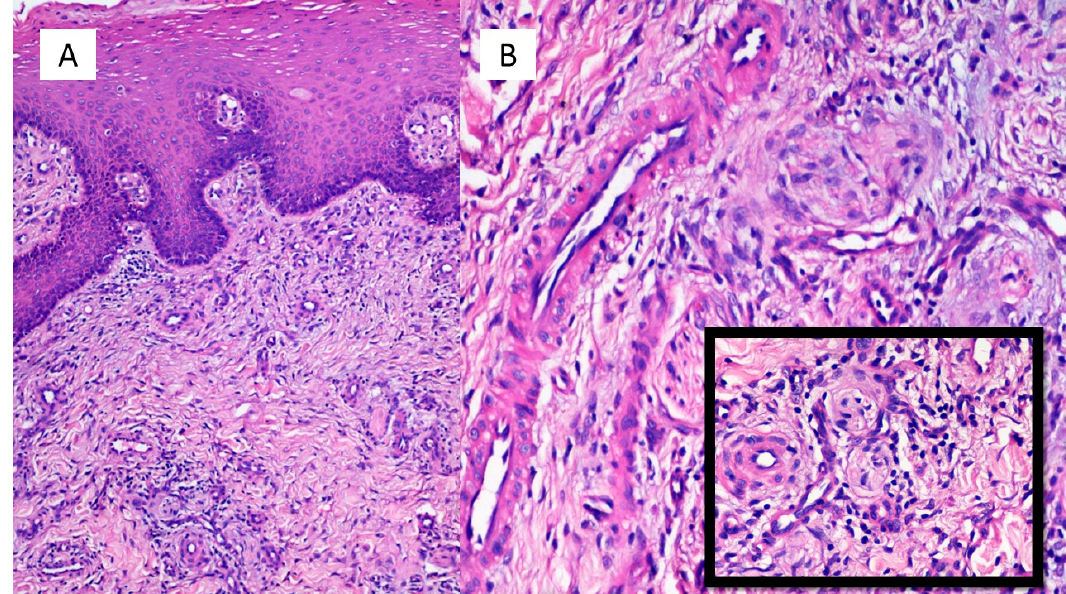
Figure 2. ( A ) Epidermis with modest hyper-parakeratosis, sometimes with a fusion of the contiguous epidermal ridges (Hematoxylin-Eosin, Original Magnification: 40×). ( B ) Evidence in superficial and middle dermis of blood vessels with endothelium often of the “hobnail” type, surrounded by a mild chronic inflammatory infiltration mainly constituted by lymphocytes and monocytes (Hematoxylin-Eosin, Original Magnification: 100×). Box: Detail of the phenomena of purpuric suffusion (Hematoxylin-Eosin, Original Magnification: 200×).